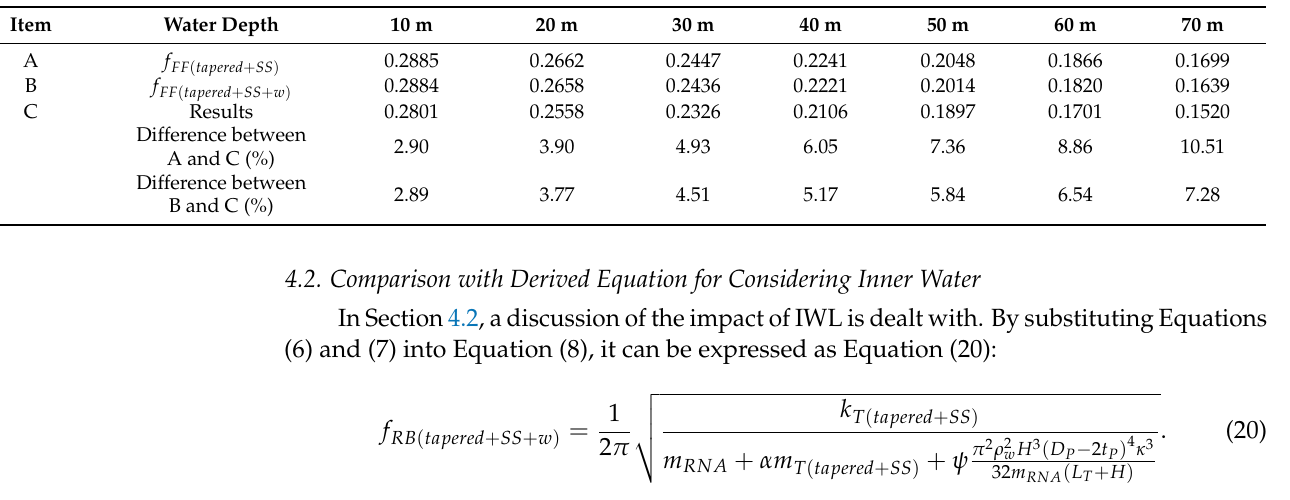
Table 9. Comparison of natural frequency estimates for flexible soil (Equation (9)) without